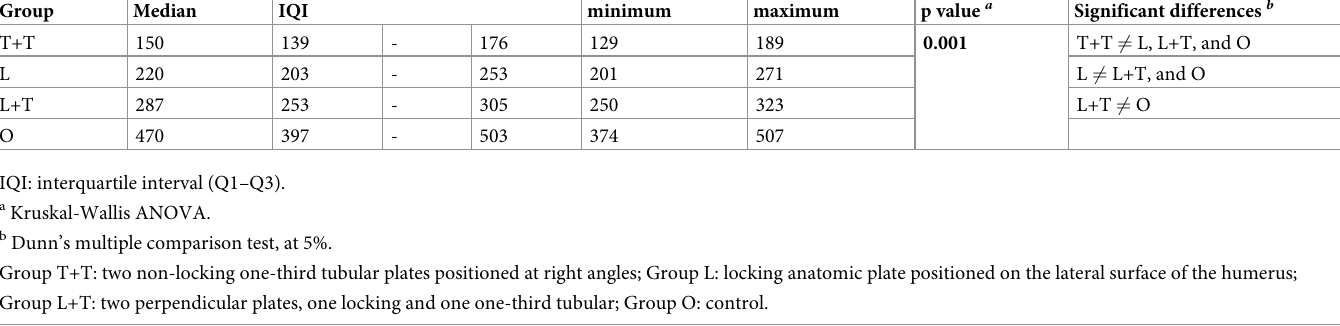
Table 3. Stiffness values (N/mm) in the four groups (T+T, L, L+T, O), and the corresponding descriptive level (p value) for the statistical tests.